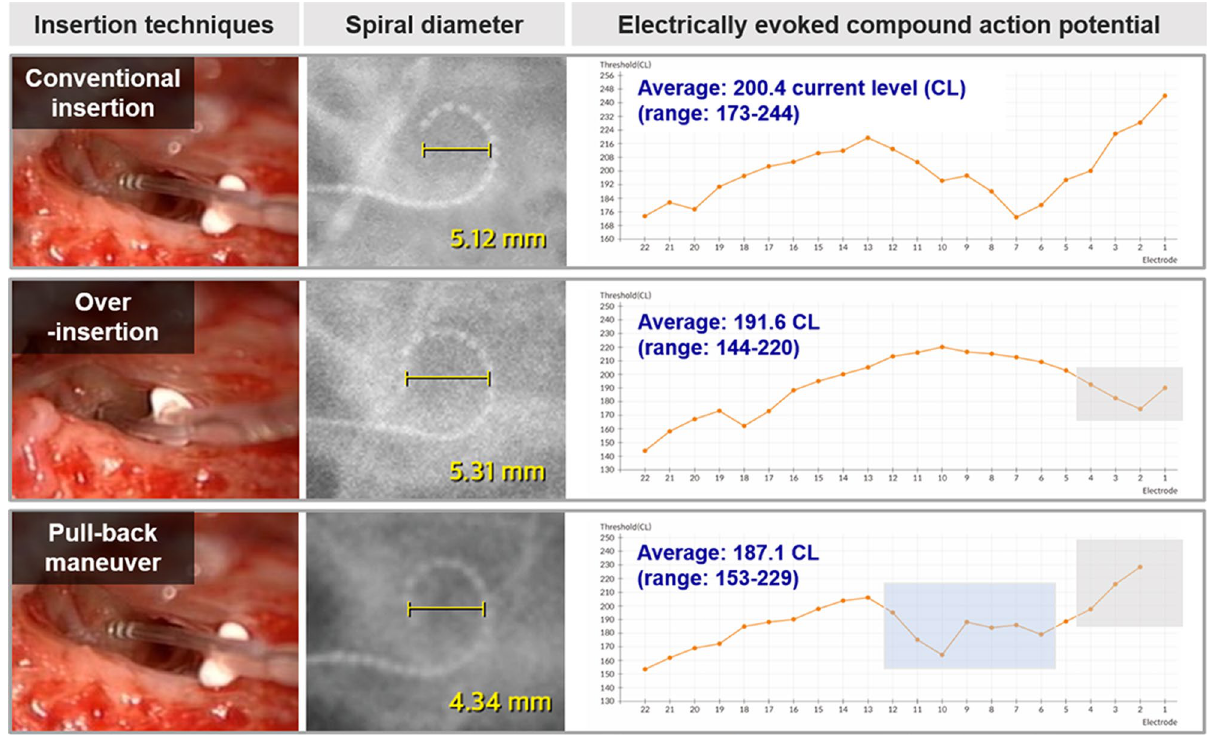
Figure 4. Serial changes in the spiral diameter of the slim modiolar electrode array, and electrically evoked compound action potential threshold during three insertion techniques. A representative case showing a differential spiral diameter depending on the insertion technique. This female patient is 23 months old at the time of examination and manifested bilateral deafness with congenital onset. The slim modiolar electrode arrays can be advanced or retreated with reference to three white markers of the electrode array and their relationship with the round window, facilitating a finely tuned insertion technique. Specifically, the pull-back maneuver-assisted insertion led to a significantly shorter spiral diameter based on intraoperative simple X-ray (i.e., cochlear view), compared with conventional and over-insertion. However, the angular insertion depth remained unchanged even after the pull-back maneuver-assisted insertion, compared with over-insertion. During the procedure, over-insertion led to reduced ECAP thresholds of the last four basal electrodes (Electrode 1–Electrode 4, gray rectangular box), compared with conventional insertion. Subsequently, pulling-back the electrode significantly reduced thresholds for the upper basal and middle electrodes (Electrode 6–Electrode 12, blue rectangular box), while again elevating ECAP thresholds of the last four basal electrodes (Electrode 1– Electrode 4, gray rectangular box) similar to the those of conventional